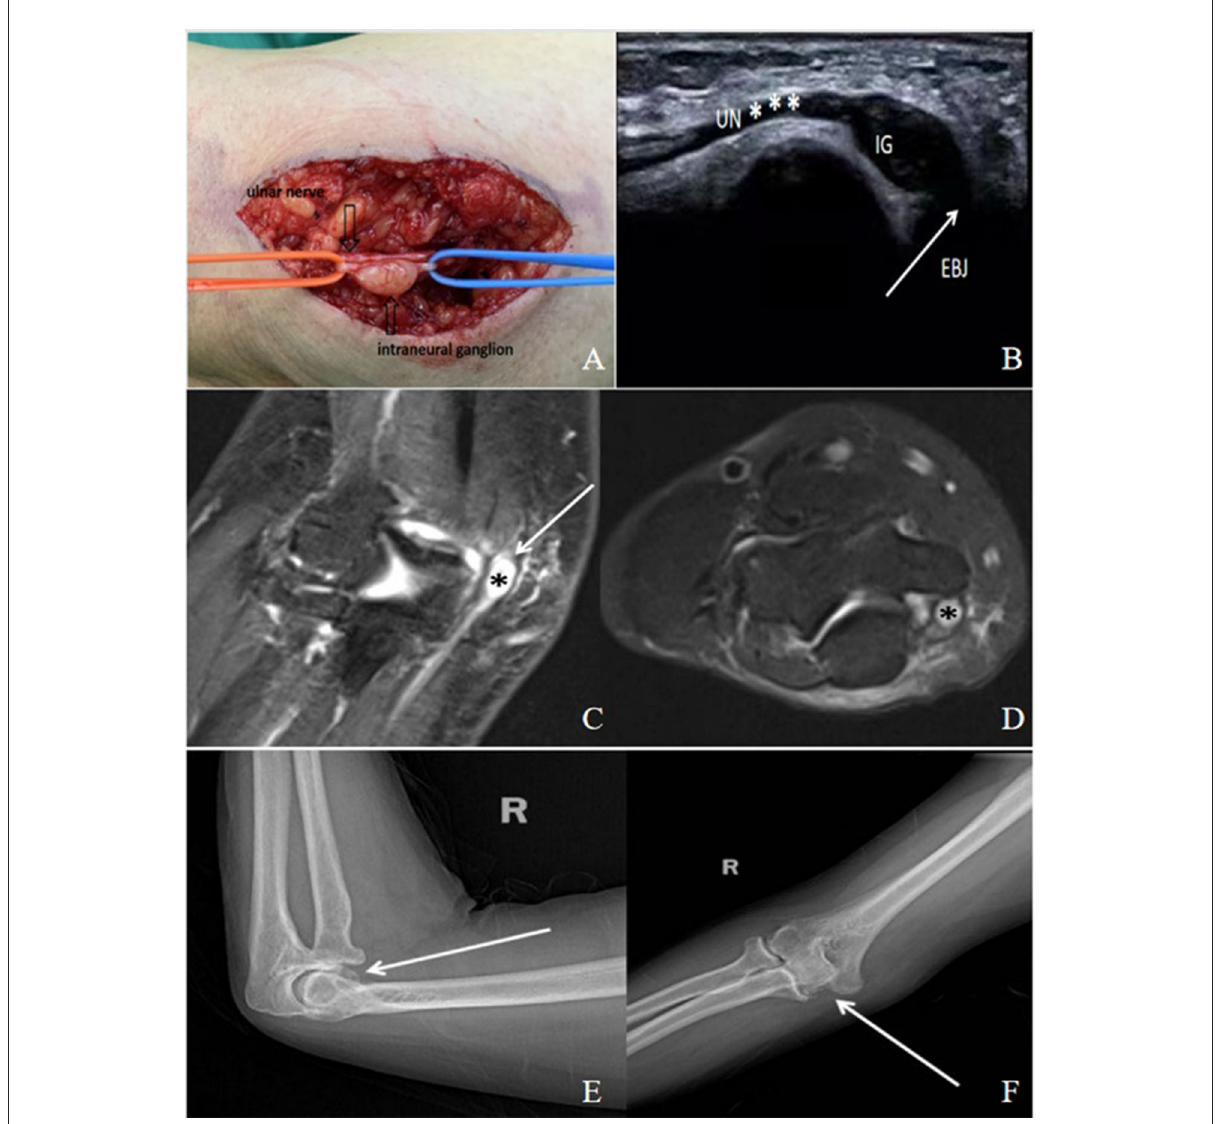
FIGURE1 A 45-year-old male patient with cubital tunnel syndrome caused by intraneural ganglion (IG). (A) An intraneural ganglion (IG) was found within the ulnar nerve (UN * ) in the cubital tunnel. (B) An ultrasound image shows an intraneural cyst extending along the ulnar nerve. EBJ: elbow joint. (C,D) There was a close link between the source of the intraneural cyst and the elbow joint, which is shown in the MRI (arrow). The intraneural ganglion ( * ) is shown as (C) , a high signal in T2STIR in sagittal view, and (D) a high signal in T2STIR in transverse view near the elbow joint. (E,F) Anteroposterior and lateral X-ray films of the elbow joint, showing the existence of elbow arthritis